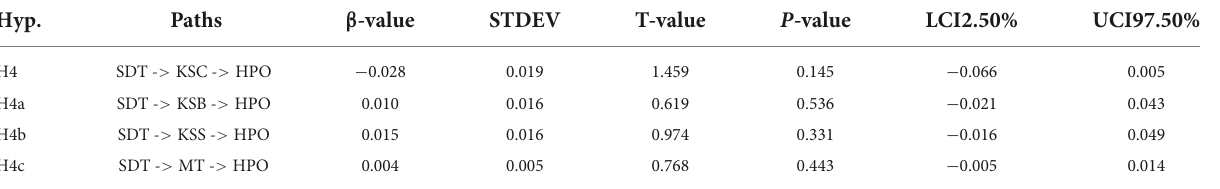
TABLE 6 Mediation hypothesis